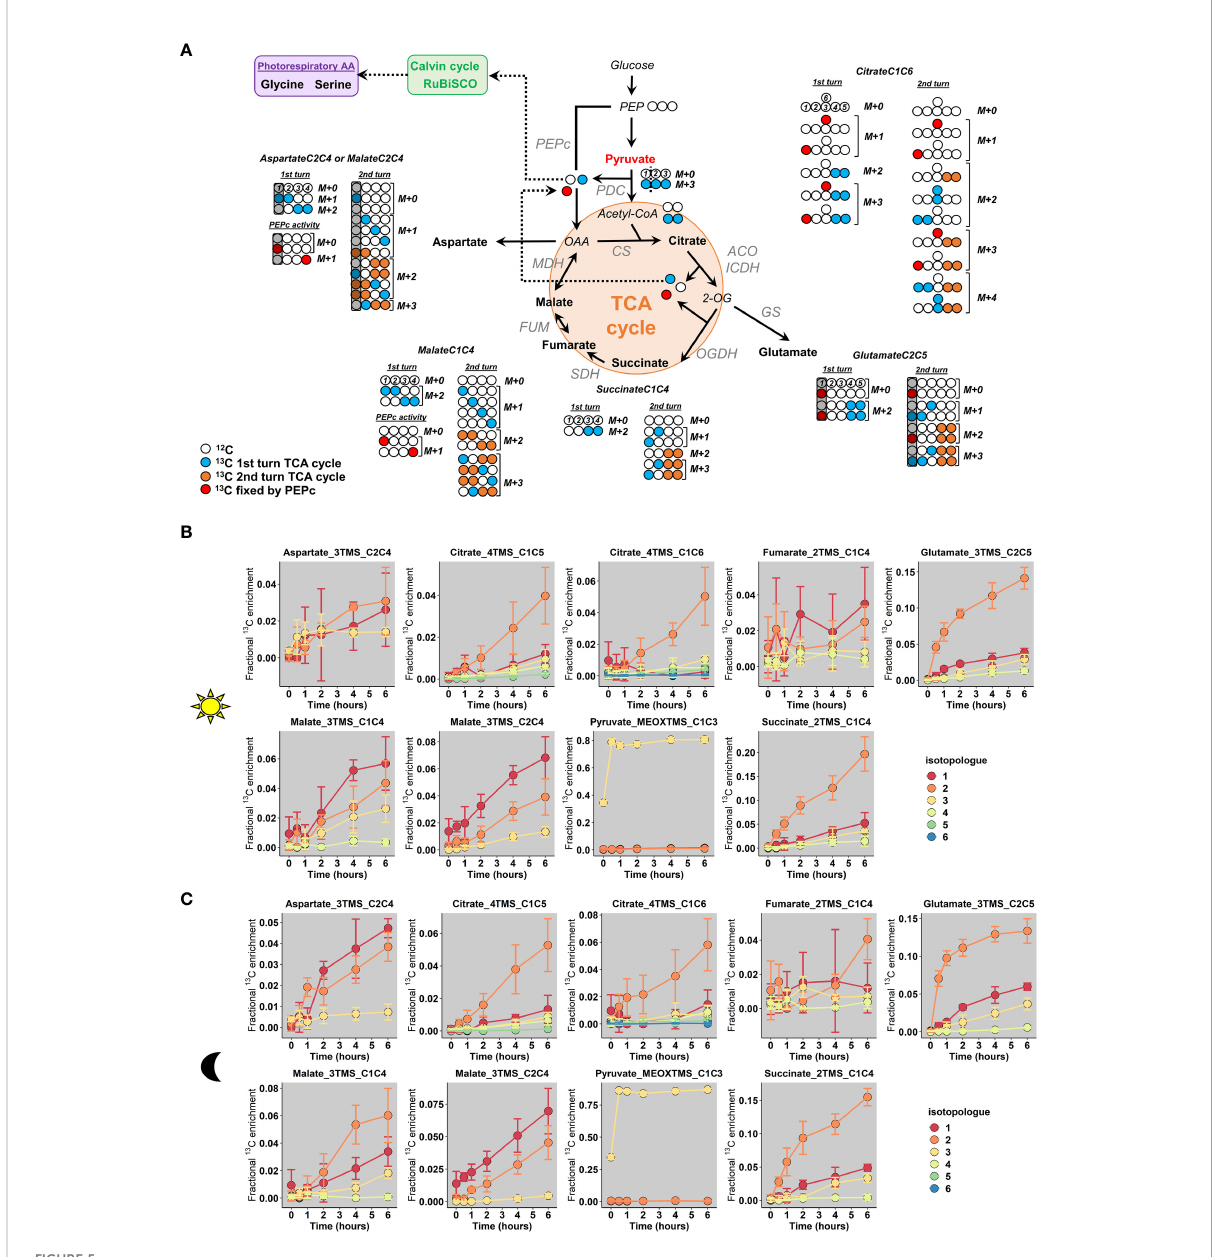
FIGURE 5 Fractional 13 C enrichment at the isotopologue level for TCA-cycle derived metabolites. (A) , Metabolic network considered based on the 13 C- labeling strategy. (B) , Light conditions and (C) , Dark conditions. The M0 isotopologue was not represented in the graphs to facilitate the visualization of low-enriched isotopologues. The results are presented as the mean ± SD of four independent biological replicates. The complete dataset is available in Table S2. In the proposed network, the second “ turn ” re fl ected the commitment of a molecule that has already experienced all reactions of the TCA cycle to another round of reactions (Orange and blue labels to compare acetyl-CoA-derived labeling from 1 st and 2 nd “ turn ” ). Note that M0 istopologues of all metabolites will still continue to produce M0 istopologues at an important rate after a “ turn ” of the TCA cycle, given the 13 C-enrichment for acetyl-CoA active pool. PEPc, Phosphoenolpyruvate carboxylase; PDC, Pyruvate dehydrogenase complex, CS, Citrate synthase; ACO, Aconitase; ICDH, Isocitrate dehydrogenase; OGDH, 2-oxoglutarate dehydrogenase; SDH,